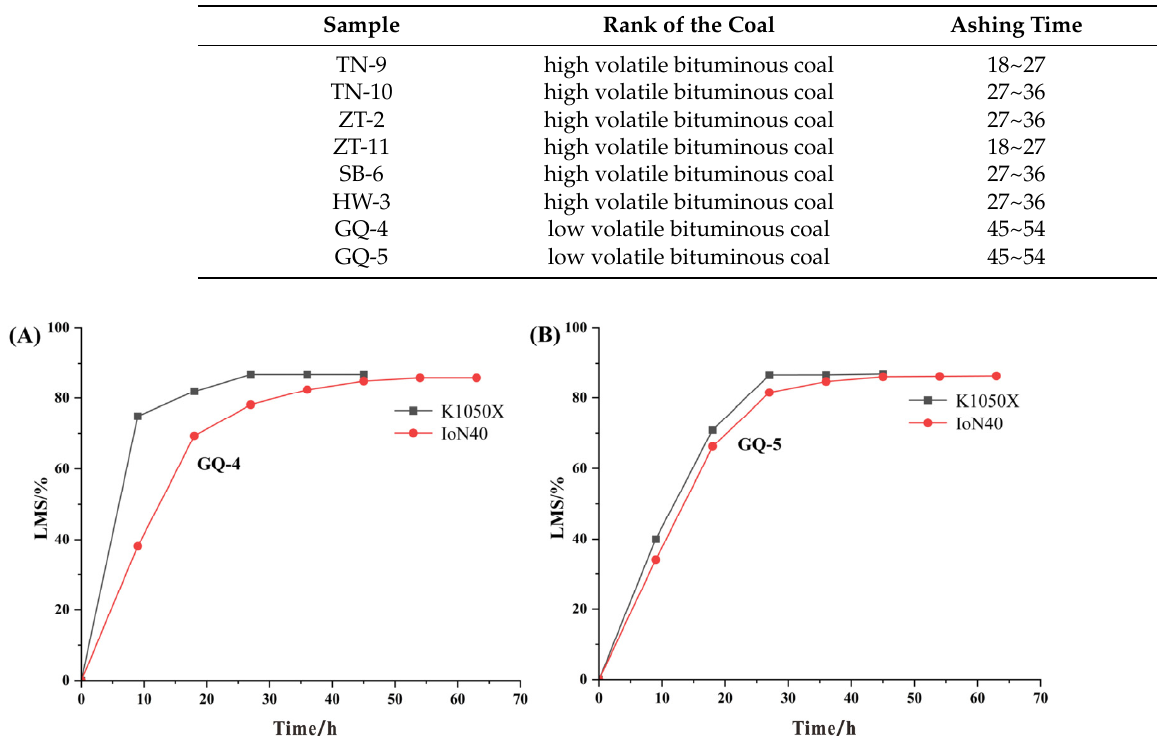
Figure 7. The variation in LMS of the samples GQ-9 ( A ) and 10 ( B ) by the ashers IoN 40 and K1050X.